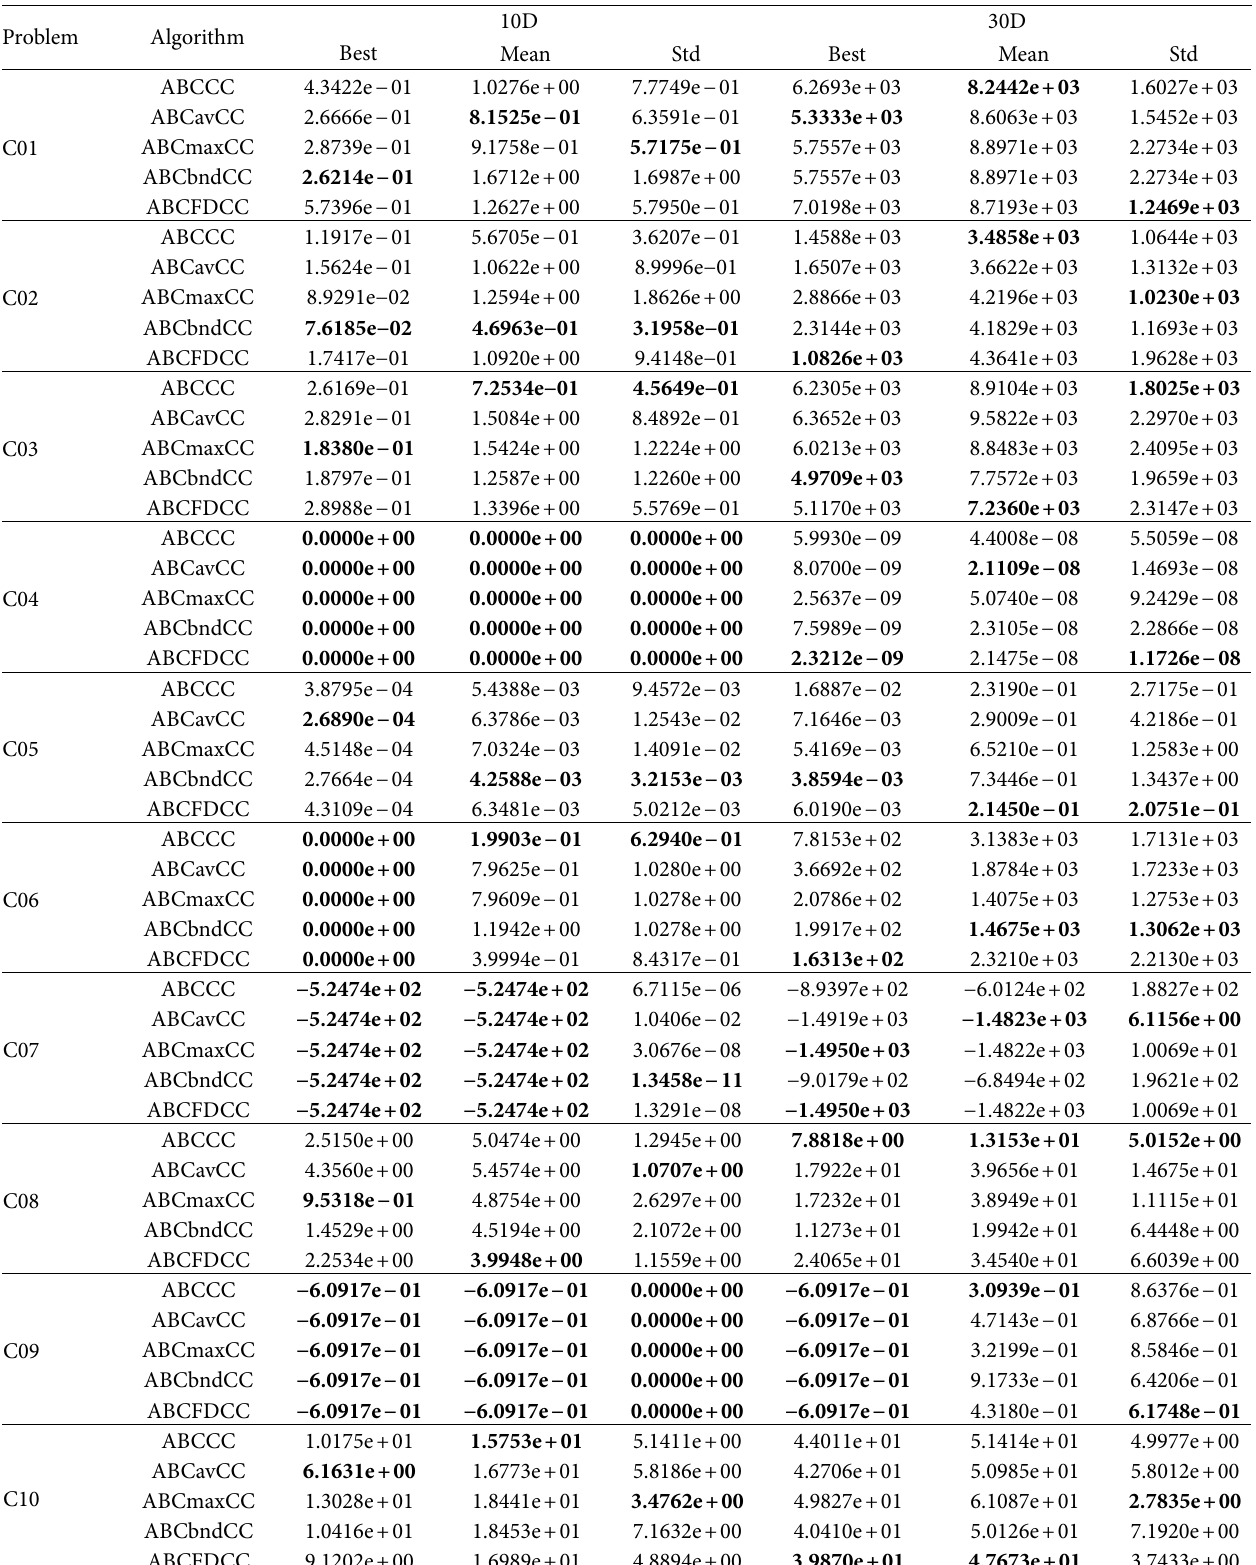
Table 6: Comparison results of the proposed algorithm with other